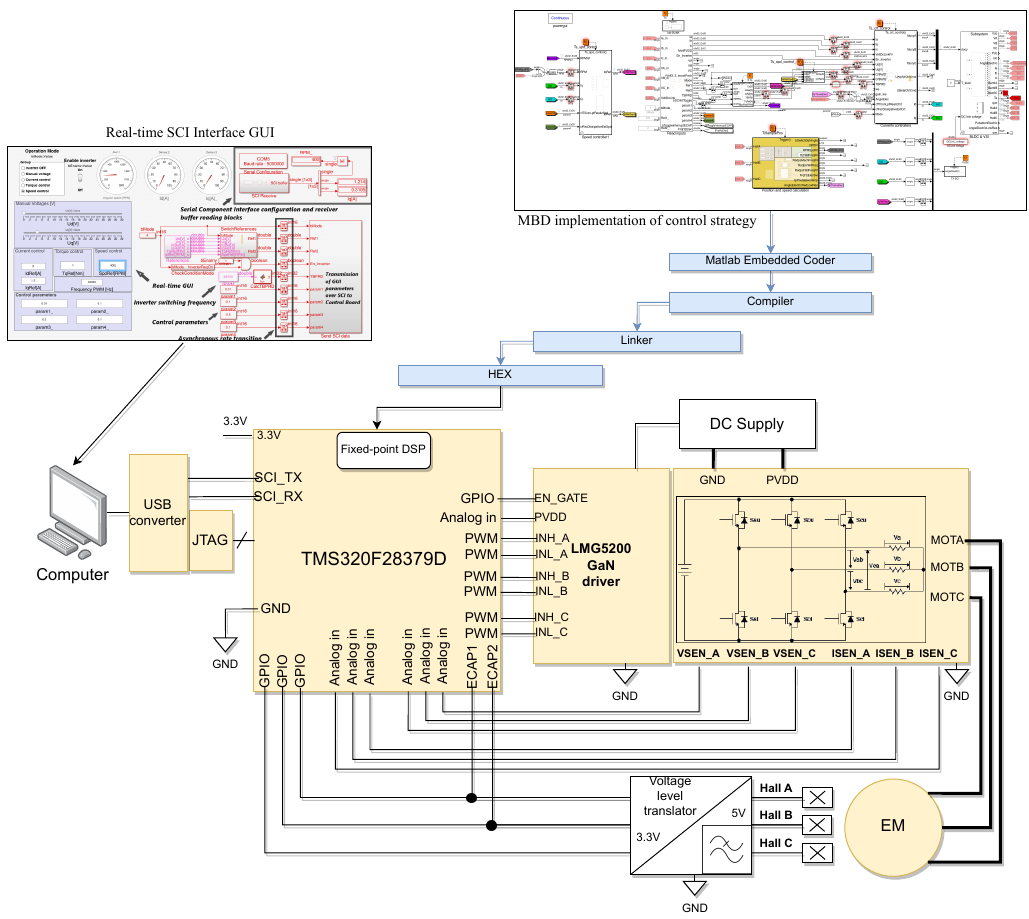
Figure 4. Illustration of the electrical connections between DSP and GAN inverter.